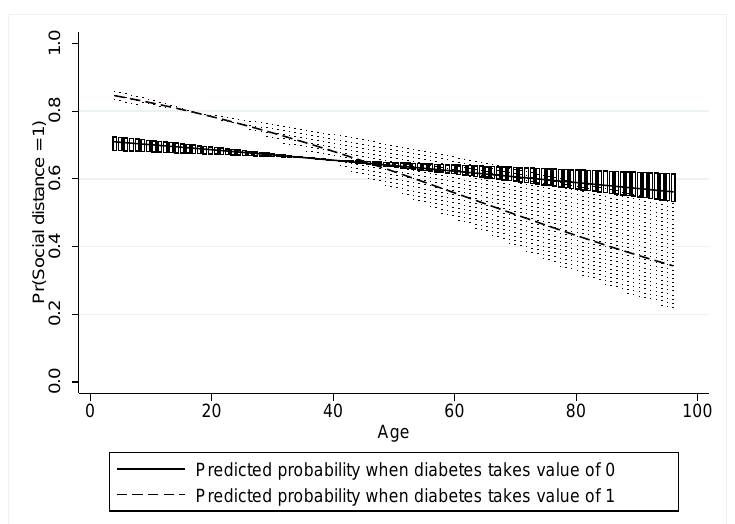
Figure 11. The interaction of age and diabetics in household under social distancing.